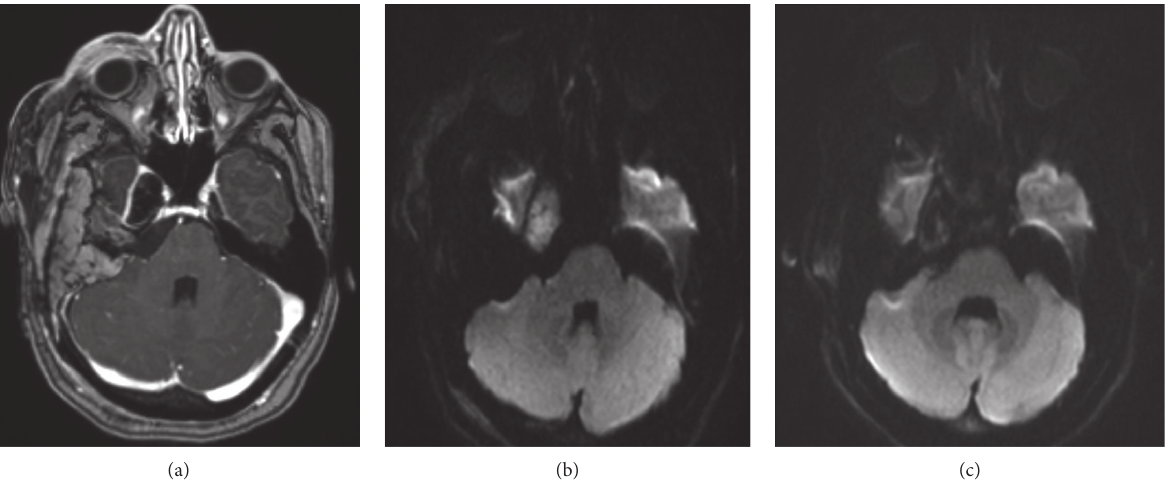
Figure 2: Imaging of patient 2. (a) Preoperative contrast-enhanced axial T1 MRI, showing peripheral enhancement of the cyst wall. (b) Diffusion restriction noted in the lesion preoperatively. (c) Postoperative resolution of diffusion restriction within the lesion.